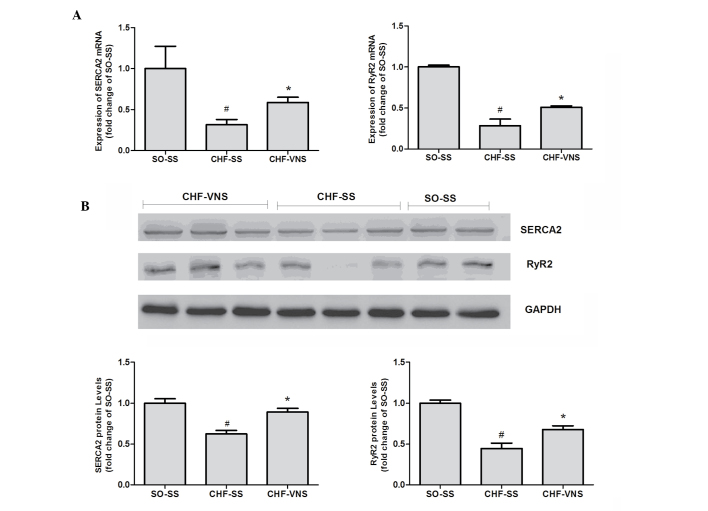
Myocardial mRNA and protein expession levels of RYR2 and SERCA2 in the SO-SS (n=5), CHF-SS (n=9) and CHF-VNS (n=9) treatment groups. (A) mRNA expression levels of RYR2 and SERCA. (B) Representative western blot of RYR2 and SERCA2, and corresponding GAPDH bands. The band intensities were normalized to the SO-SS values shown. Assessment was made following treatment for 72 h. Data are presented as the mean ± standard deviation. *P<0.05, compared with CHF-SS; #P<0.05, compared with SO-SS.